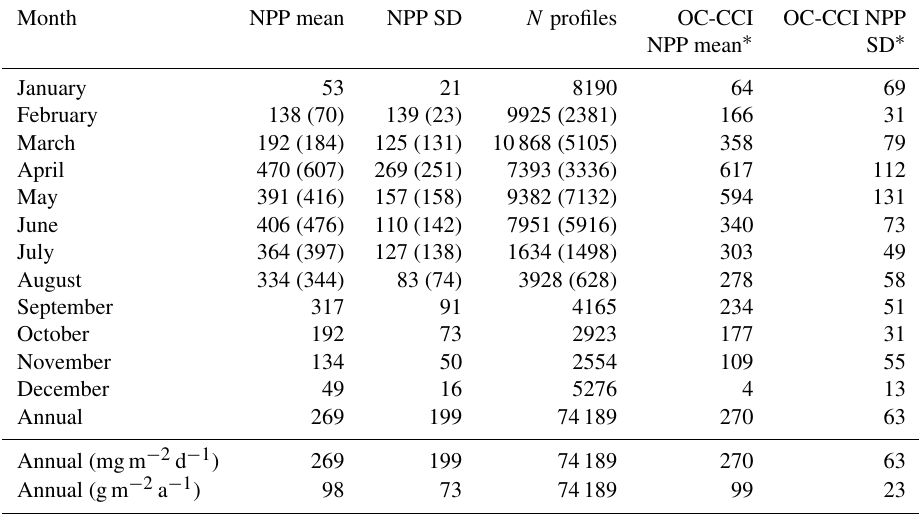
Table 5. Monthly statistics for SEO-PAR-based depth-integrated primary production estimates across all glider missions. Values for in situ PAR-based depth-integrated primary production estimates are given in brackets where available. All measurements are given in carbon flux, measured in grams per square metre per day, unless otherwise specified. The final column gives the mean primary production extracted